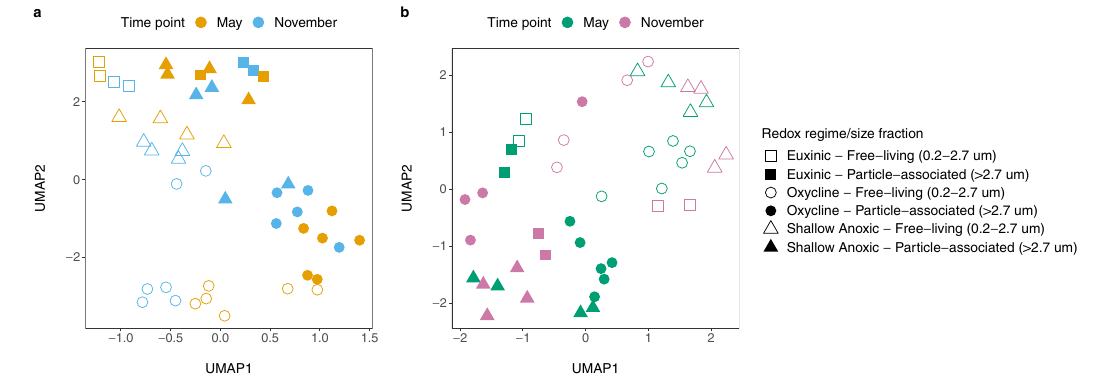
Fig. 3 | Uniform manifold approximation and projection (UMAP) analysis of metagenomic and metatranscriptomicreads recruited to BGCs. UMAPanalysis for read mapping data of particle-associated and free-living metagenomes ( a ) and metatranscriptomes ( b ) to all BGCs longer than 10kb total length detected in